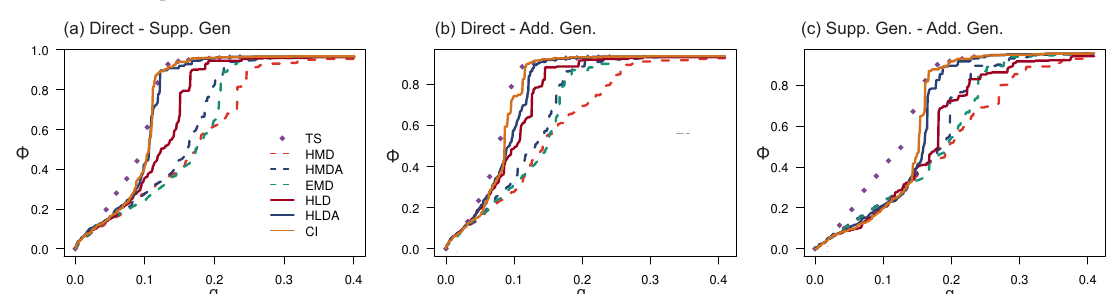
Figure 4. Optimal disintegration strategies in multiplex Caenorhabditis Melanogaster neural networks under layer node-based attack. For the TS algorithm, we use the maximum value of Φ in 20 independent realizations.